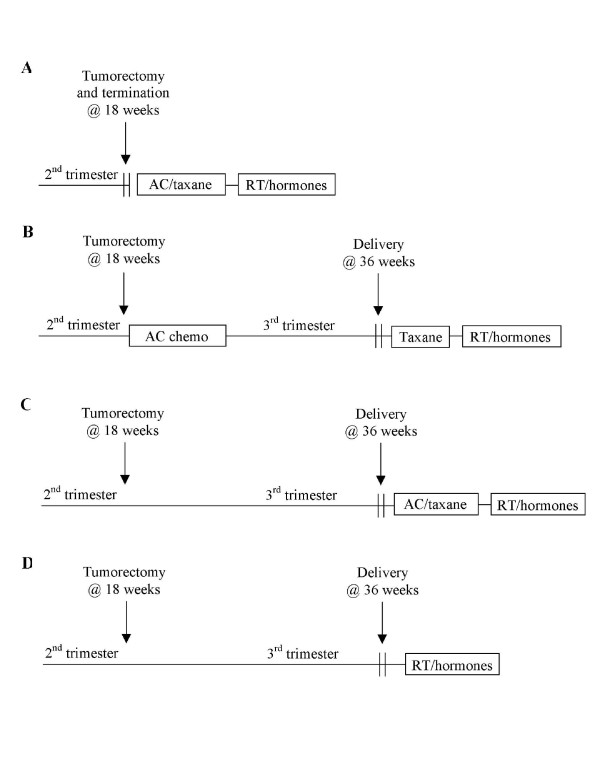
Schematic representation of patient choices for adjuvant therapies in resectable primary breast cancer diagnosed in the second or third trimesters. A, Immediate termination; B, Chemotherapy during pregnancy; C, Chemotherapy after pregnancy; D, No chemotherapy.